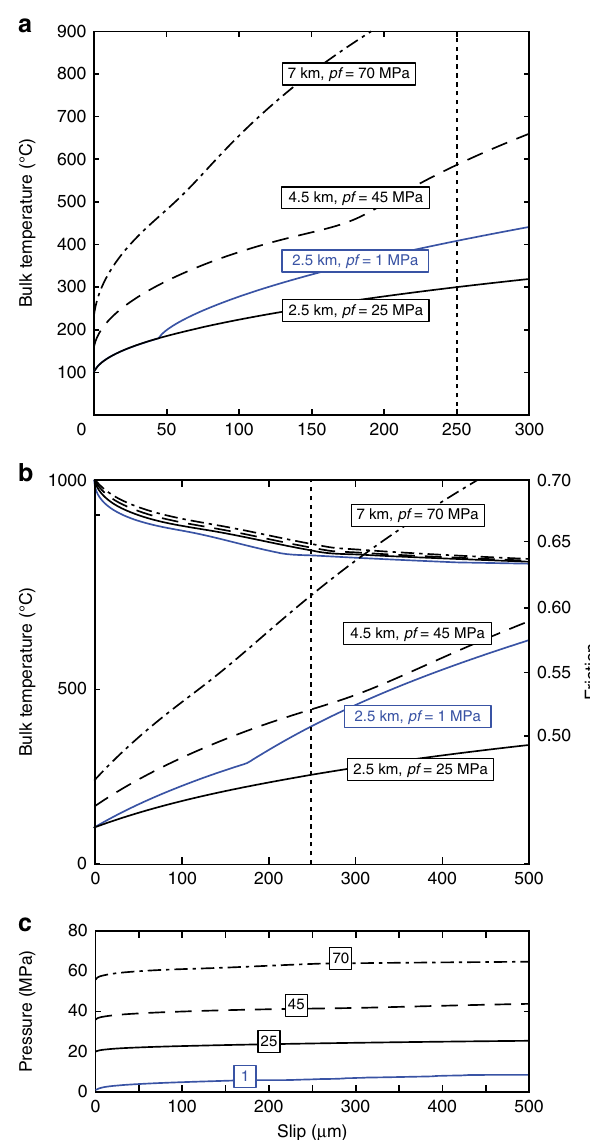
Fig. 6 Bulk fault temperature at 1 m s − 1 slip rate, at upper crustal depths. Blue curves correspond to low fl uid pressure conditions (1 MPa) and black to high fl uid pressures (25, 45 and 70 MPa). Vertical dotted lines show the maximum slip in our experiments. a Bulk temperature reached in the fault during shear heating under drained conditions versus slip (e.g. Methods). b Bulk temperature (left y axis) reached in the fault during shear heating under undrained conditions and the corresponding friction evolution due to TP (right y axis) versus slip (e.g. Methods); each curve corresponds to the labelled depth. c Pore pressure evolution in the fault during shear heating versus slip for the different initial fl uid